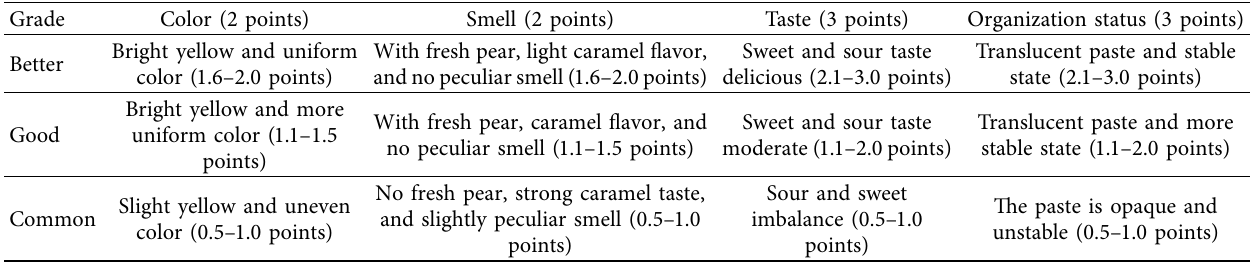
Table 1: Sensory evaluation of “Yali” pear